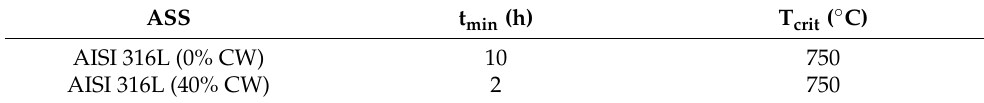
Table 6. Parameters of C-curves’ critical areas T crit and t min for particular TTS diagrams. ASS t min (h) T crit ( ◦ C) AISI 316L (0% CW) 10 750 AISI 316L (40% CW) 2